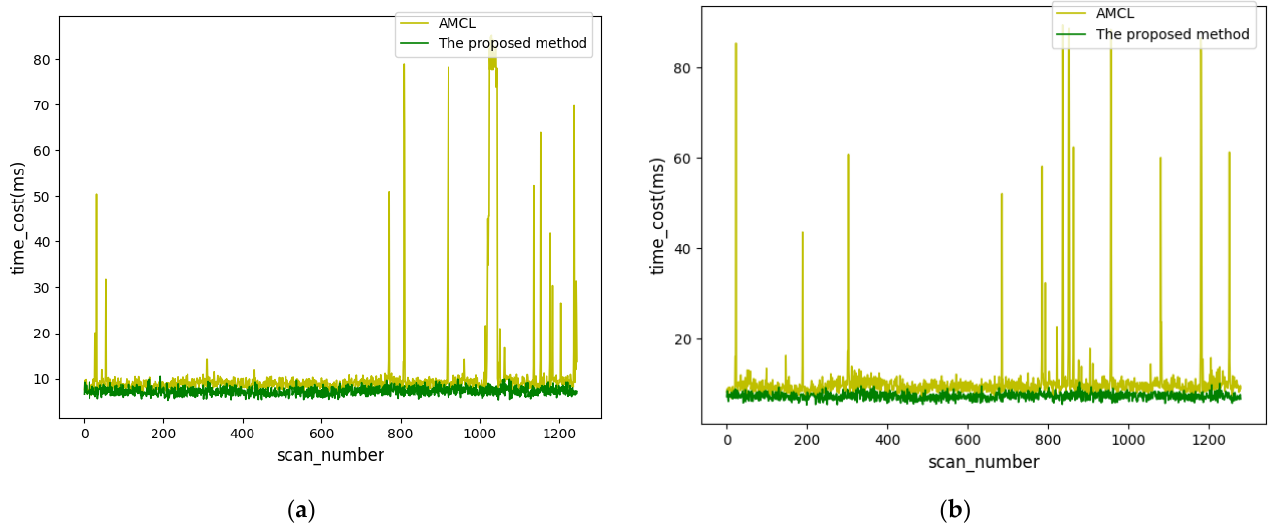
Figure 13. The comparison of time–cost. ( a ) case 1; ( b ) case 2. Table 3. The comparison of mean time–cost in case 1 and case 2, respectively.